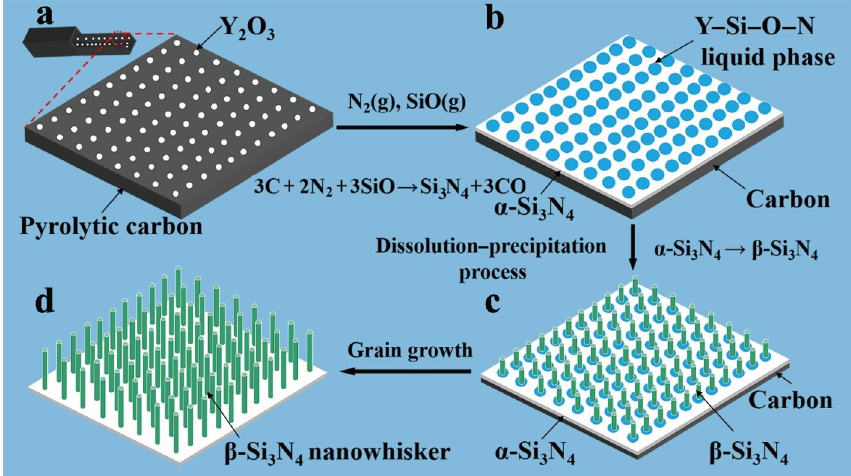
Schematic illustration of β -Si 3 N 4 nanowhisker array growth mechanism. (a) C B -template coating with Y 2 O 3 nanoparticles was formed. (b) α -Si 3 N 4 crystallines and Y–Si–O–N liquid phase on the surface of the C B -template were obtained. (c) Phase transformation of α - to β -Si 3 N 4 occurred, and new α -Si 3 N 4 crystallines were formed. (d) Grain growth of β -Si 3 N 4 nanowhisker